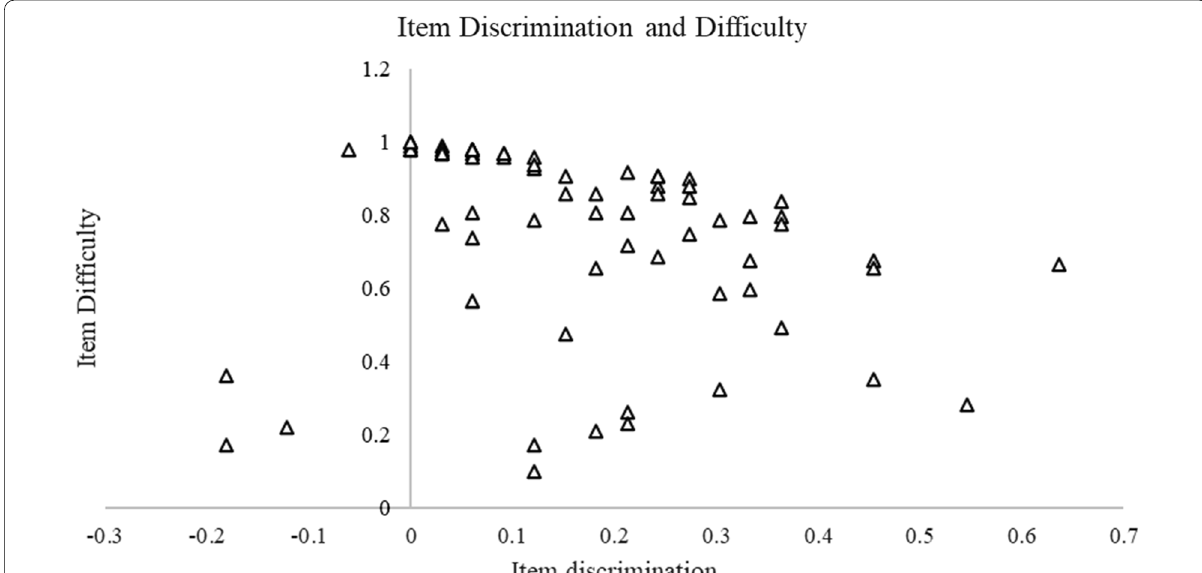
Fig. 3 Item difficulty and discrimination values for the PSKA, in Spring 2019. Each triangle represents an item; these are ordered based on their difficulty and discrimination values. For item difficulty, lower values indicate a lower proportion of correct answers (i.e., a difficult question). For item discrimination, higher values indicate that the top-third of students outperformed the bottom-third of students